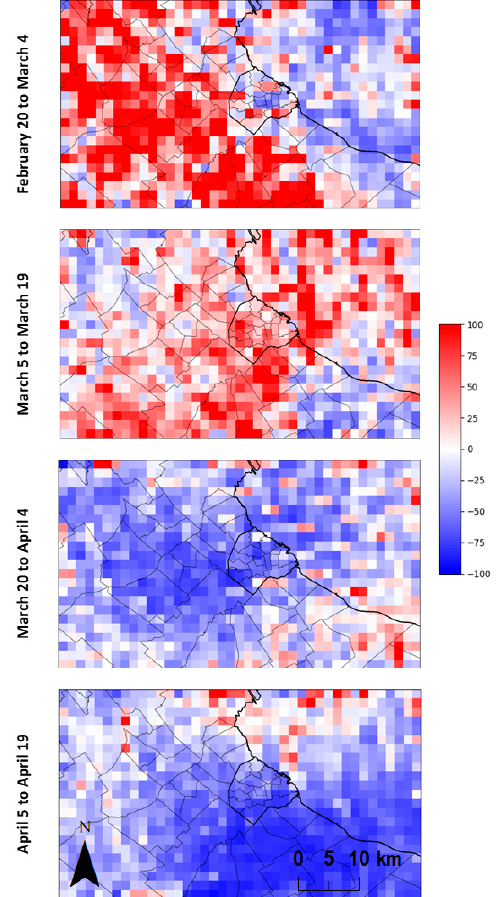
Figure A2. Di ff erences (%) between the year 2019 and 2020 of tropospheric NO 2 measured by Figure A2. Differences (%) between the year 2019 and 2020 of tropospheric NO 2 measured by the S5p/TROPOMI-ESA. Red and blue tones indicate greater/lesser concentration in 2019 and 2020 the S5p / TROPOMI-ESA. Red and blue tones indicate greater / lesser concentration in 2019 and respectively. 2020